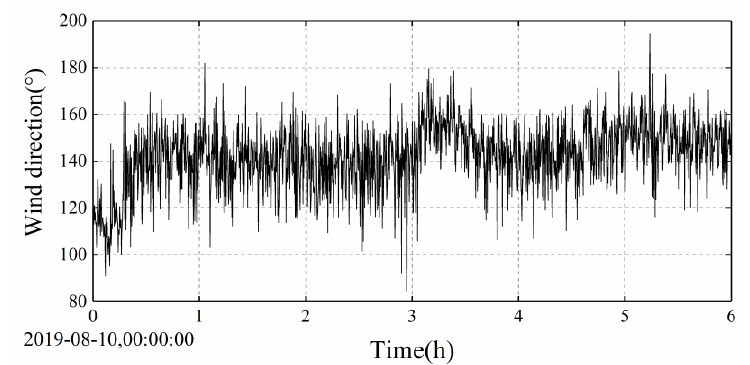
Figure 4. Measured wind samples during Typhoon Lekima.